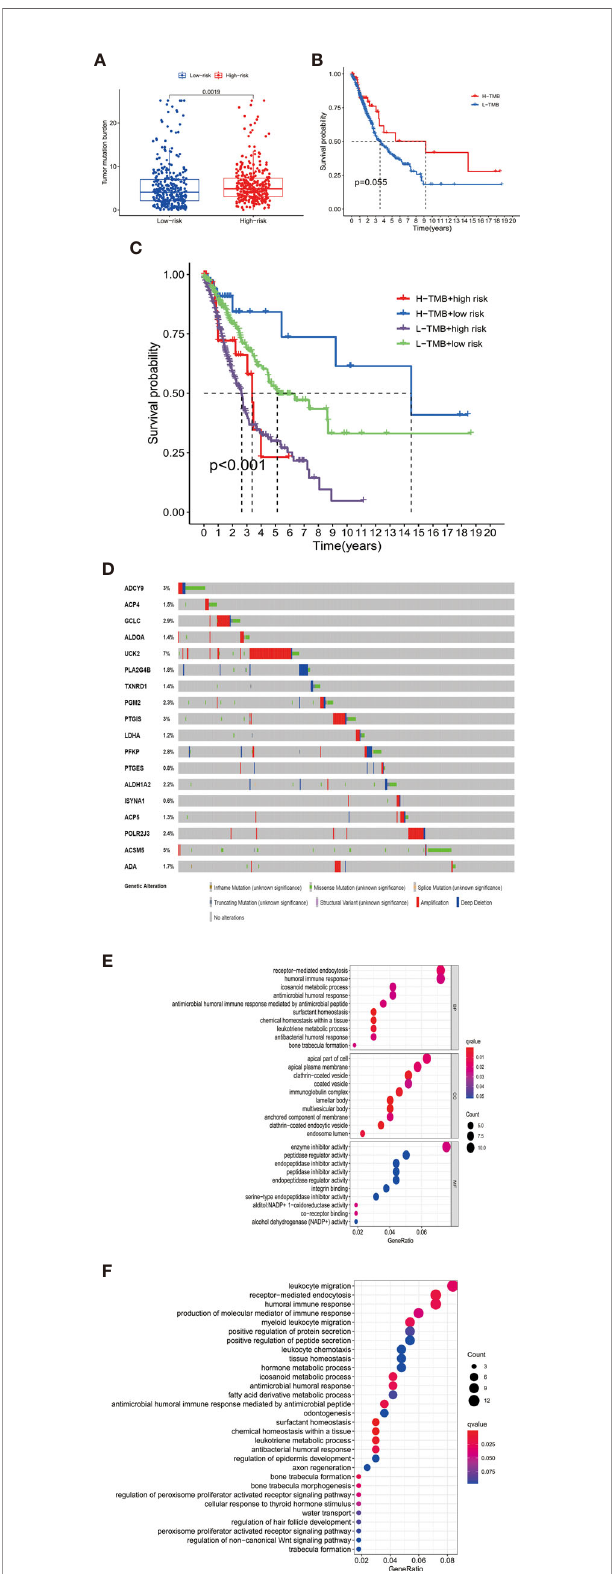
FIGURE 4 | (A) The high-risk group had a higher TMB level than the low-risk group, indicating a reverse TMB tendency compared with immunology status in high-risk patients. (B) There was no difference in survival between the high- TMB and low-TMB patients. (C) When the signature groups were added to TMB, the prognosis of patients in different subgroups showed distent survival differences. Patients with high-TMB and low-risk had best prognosis among all the groups. (D) The 18 signature genes showed varying levels of mutation in TCGA-LUAD and LUSC samples. The mutation rates of UCK2 and ACSM5 were signi fi cantly higher than that of other genes. (E, F) The barplot of Go and KEGG functional enrichment analyses. BP indicated biological process; CC indicated cellular component; MF indicated